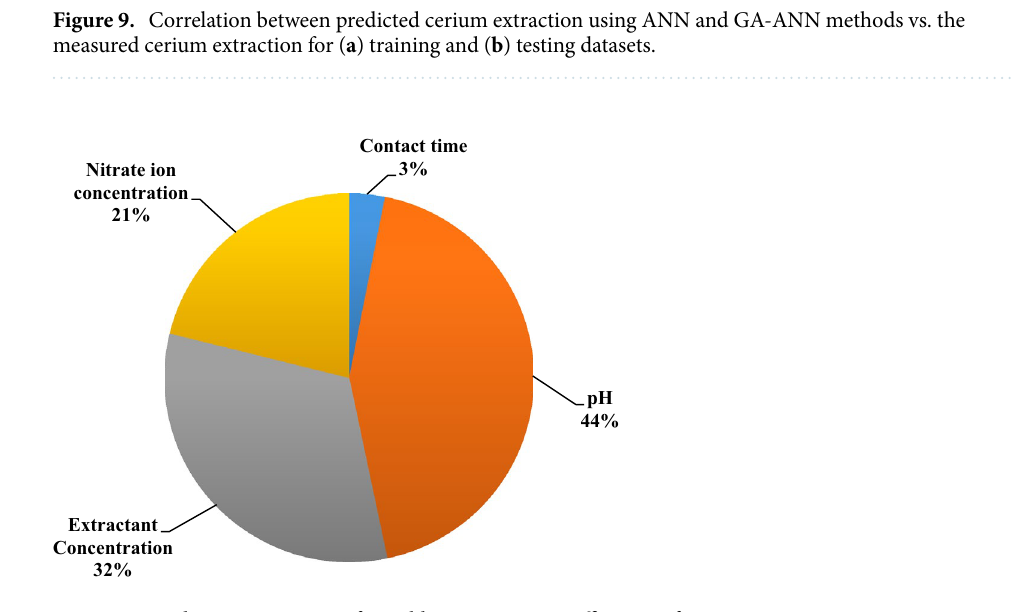
Figure 10. Relative importance of variables on extraction efficiency of